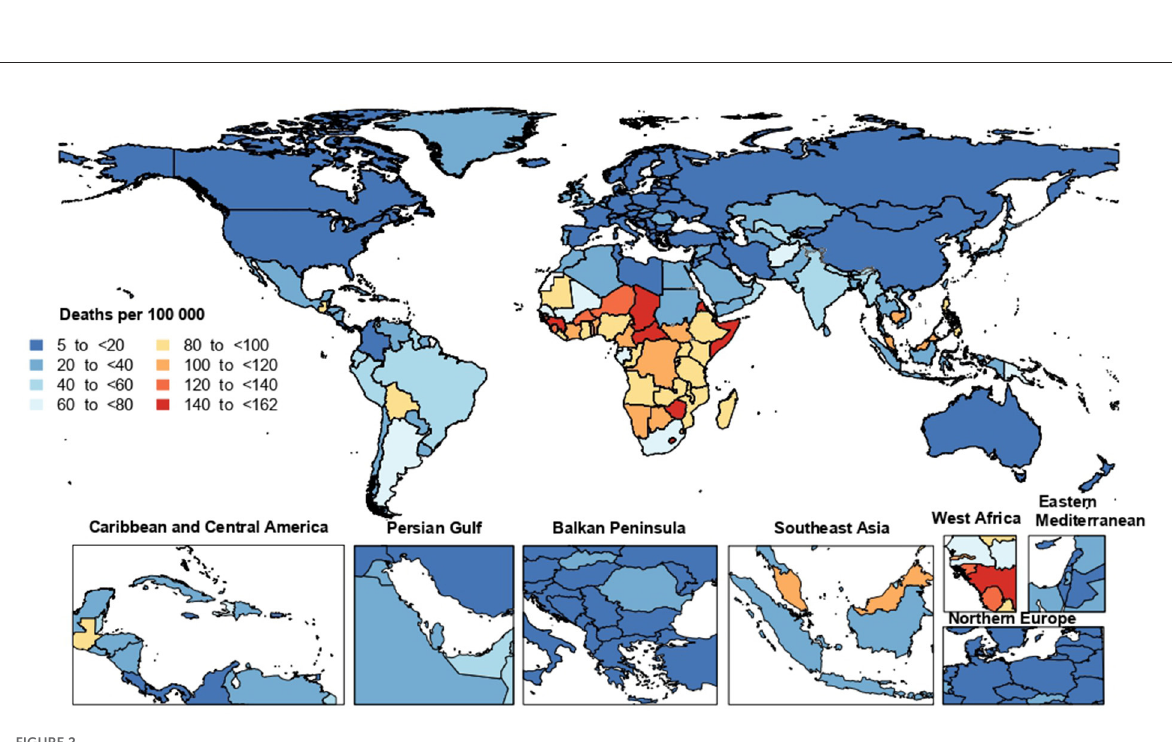
FIGURE2 Age-standardized death rate from lower respiratory infections (per 100,000) population in 2019, by country (generated from data available from